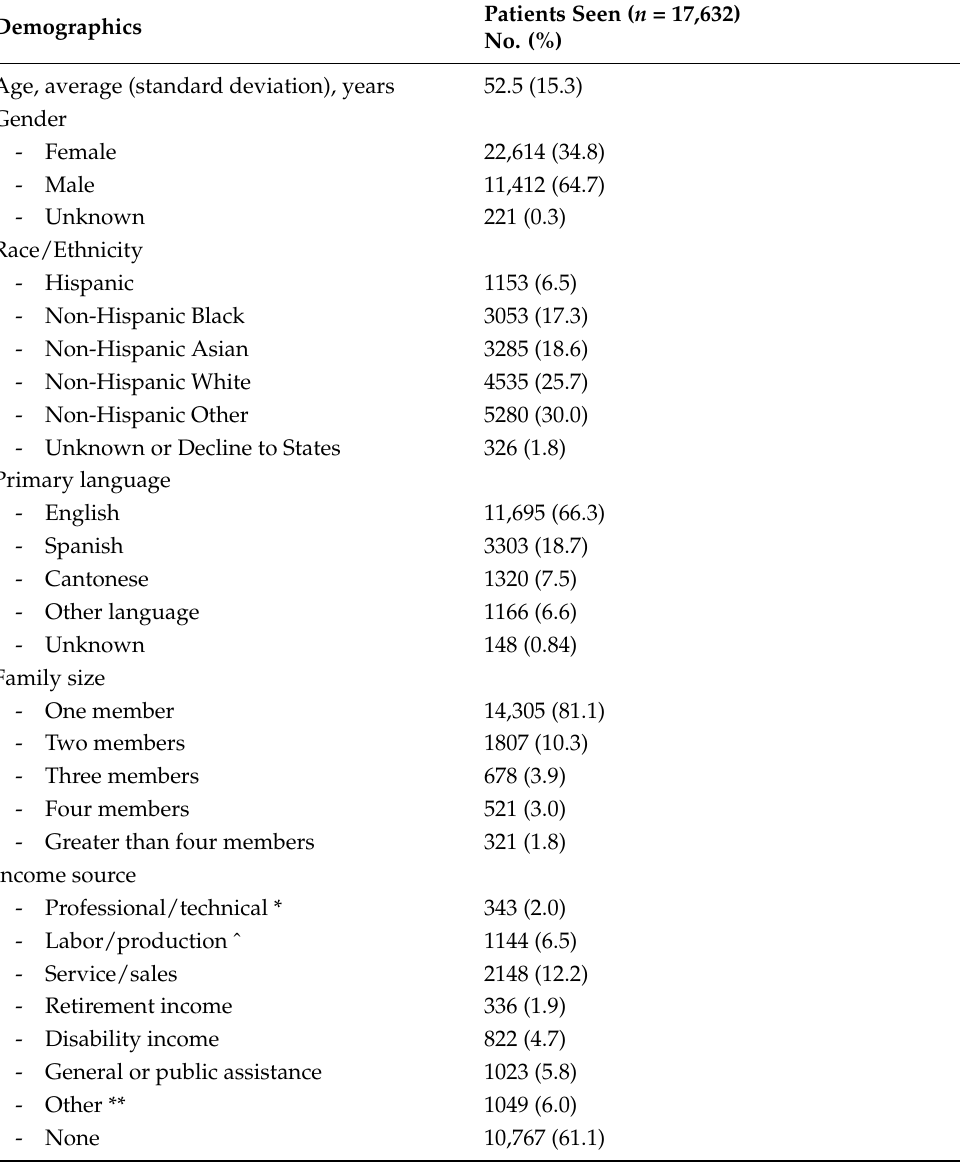
Table 1. Sociodemographics of patients seen in general surgery outpatient clinic from 2008 to